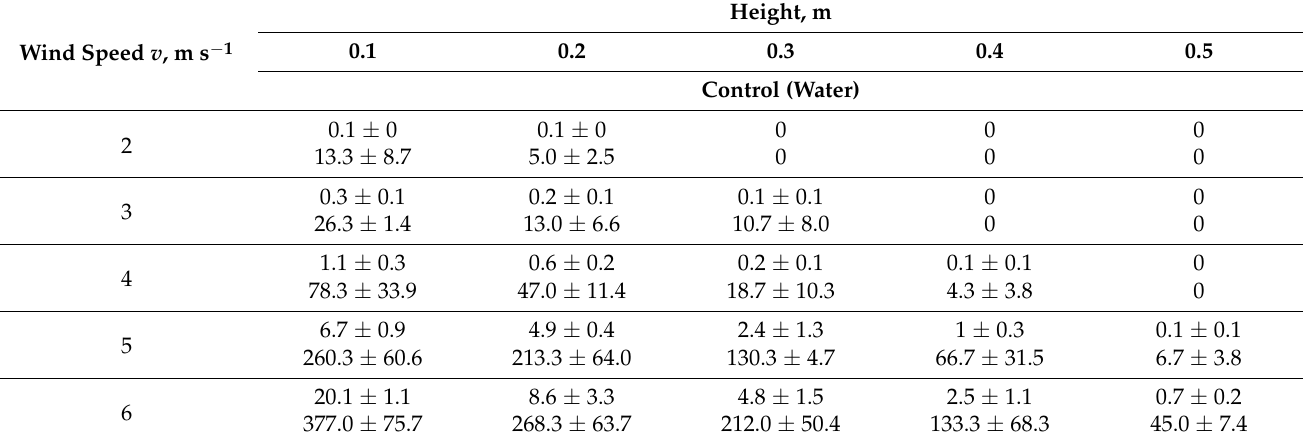
Table 2. Water-sensitive paper coverage (upper line, %) and number of droplets (lower line) with the air-injector flat spray nozzle spraying in the wind tunnel, 4 m from the nozzle (0.1–0.5 m height measured vertically in direction of the y -axis from corrugated tin, Figure